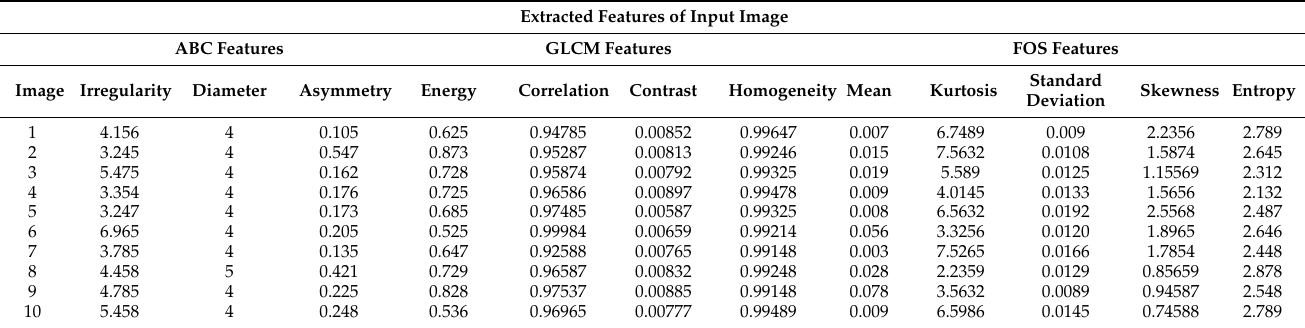
Table 3. Extracted feature parameters for ABC, GLCM and FOS features.